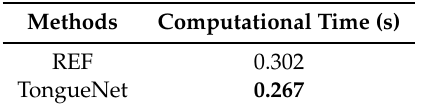
Table 5. Computation time comparison between TongueNet and